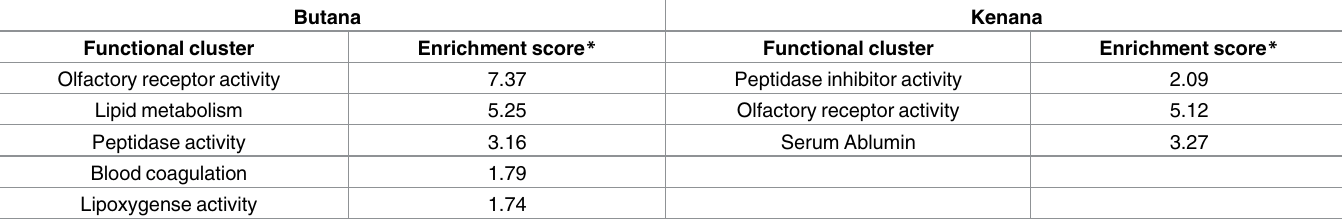
Table 1. Significantly enriched functional term clusters and their enrichment scores following DAVID analysis for genes identified in Butana and Kenana candidate regions.